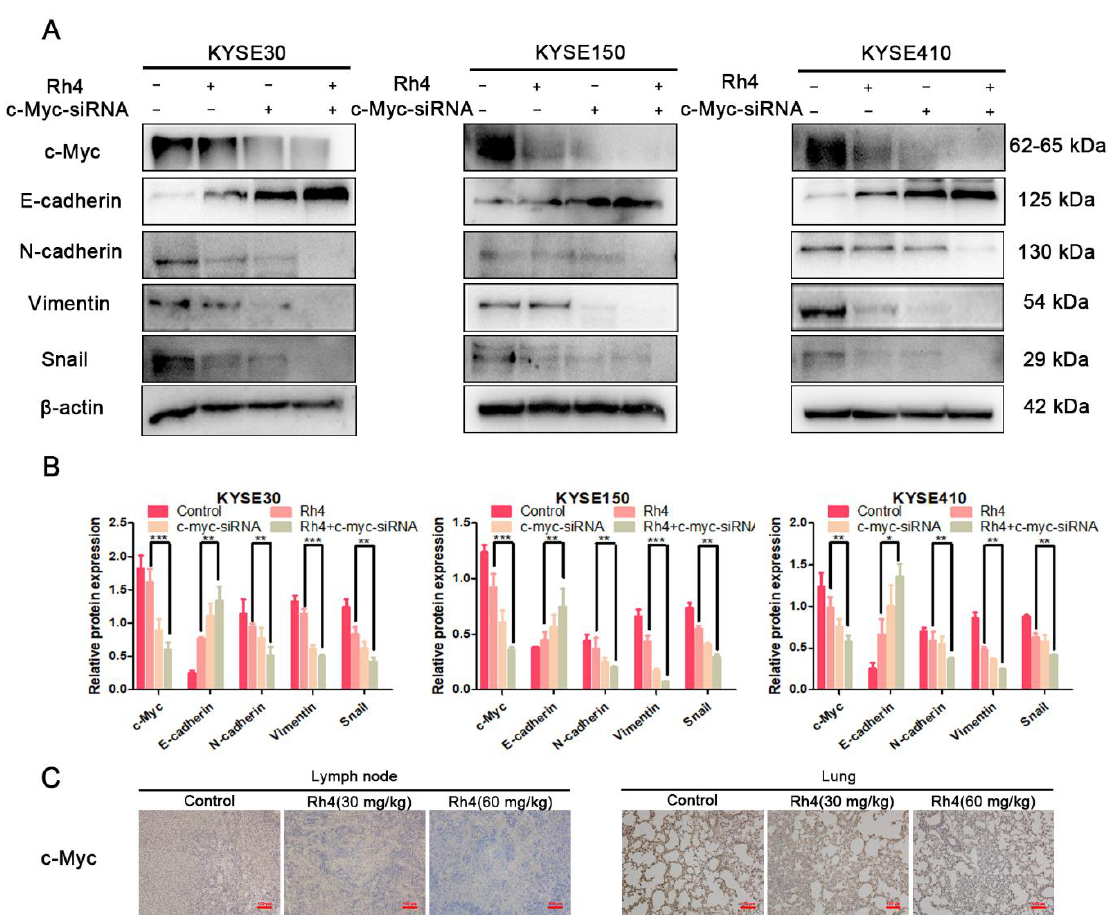
Figure 8. ( A , B ) Addition of c-Myc-siRNA enhanced Rh4 inhibition of E-cadherin, N-cadherin, Vimentin, and snail ( C ) Rh4 reduces c-Myc expression in lymph nodes and lungs in vivo. Scale bar = 100 µ m. All data are presented as mean ± SD, * p < 0.05, ** p < 0.01, *** p < 0.001.